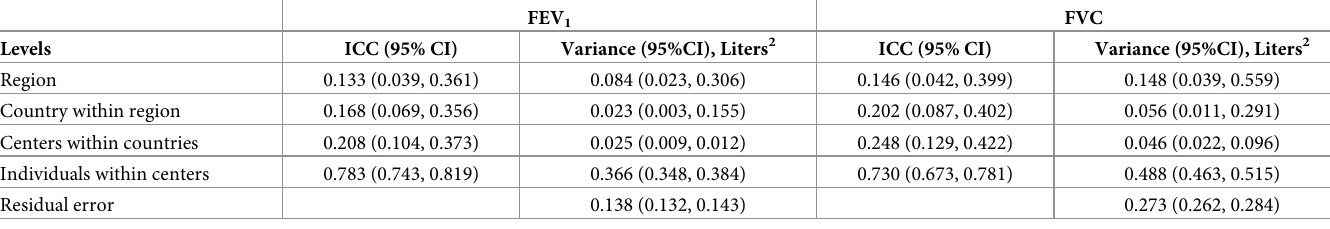
Table 3. ICC and variance estimates between spirometer at the region, country, centers and individuals levels. FEV 1 FVC Levels ICC (95% CI) Variance (95%CI), Liters 2 ICC (95% CI) Variance (95%CI), Liters 2 Region 0.133 (0.039, 0.361) 0.084 (0.023, 0.306) 0.146 (0.042, 0.399) 0.148 (0.039, 0.559) Country within region 0.168 (0.069, 0.356) Centers within countries 0.208 (0.104, 0.373) Individuals within centers Residual error 0.138 (0.132, 0.143) 0.273 (0.262, 0.284) ICC = intraclass